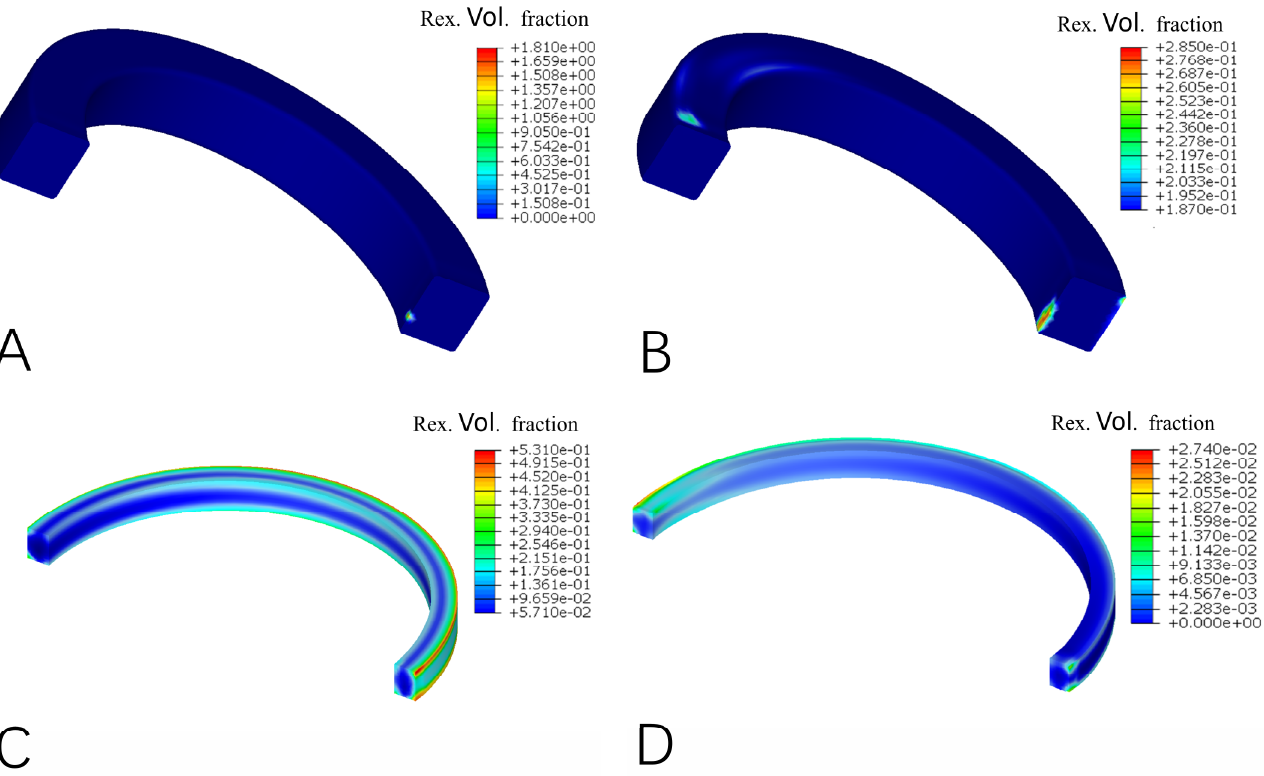
Figure 10. Distribution of DRX percentages of 2219 aluminum alloy during ring lashing: ( A ) Drive roll bite stage, ( B ) Vertebral roll bite stage, ( C ) Stable rolling stage, and ( D ) Rolling completion stage.